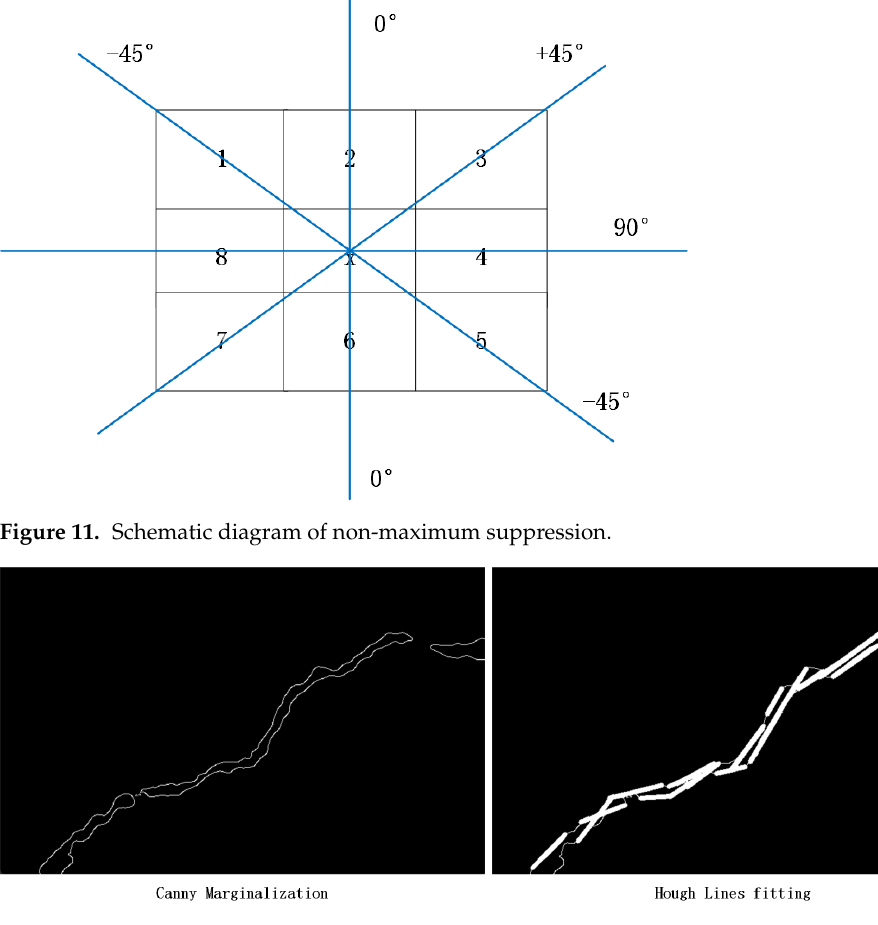
Figure 12. Canny operator & Hough line fitting